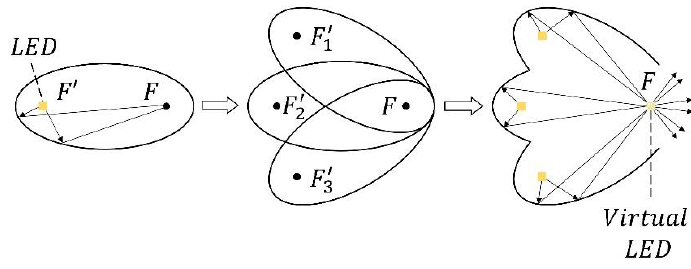
Figure 2. Schematic representation of multi-channel reflector.